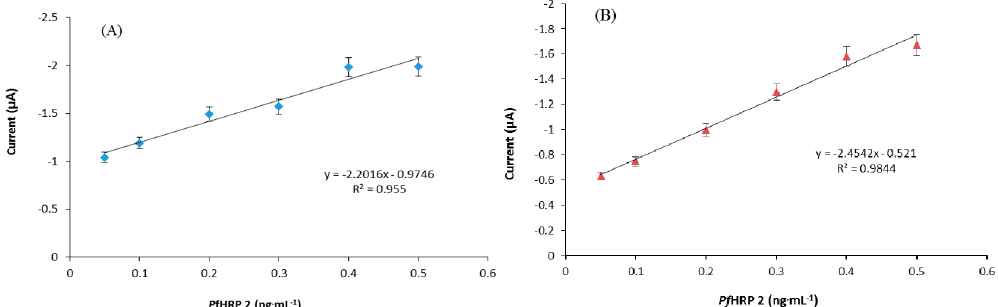
Figure 6. Linear regression of the chronoamperometric response of Pf HRP 2 detection in buffer (PBS, 0.01M, pH 7.4, spiked with 0.05–0.5 ng·mL − 1 Pf HRP 2) ( A ) and 100 % spiked serum samples (Commercial human serum samples spiked with 0.05–0.5 ng·mL − 1 Pf HRP 2) ( B ) on JD2 sensors using